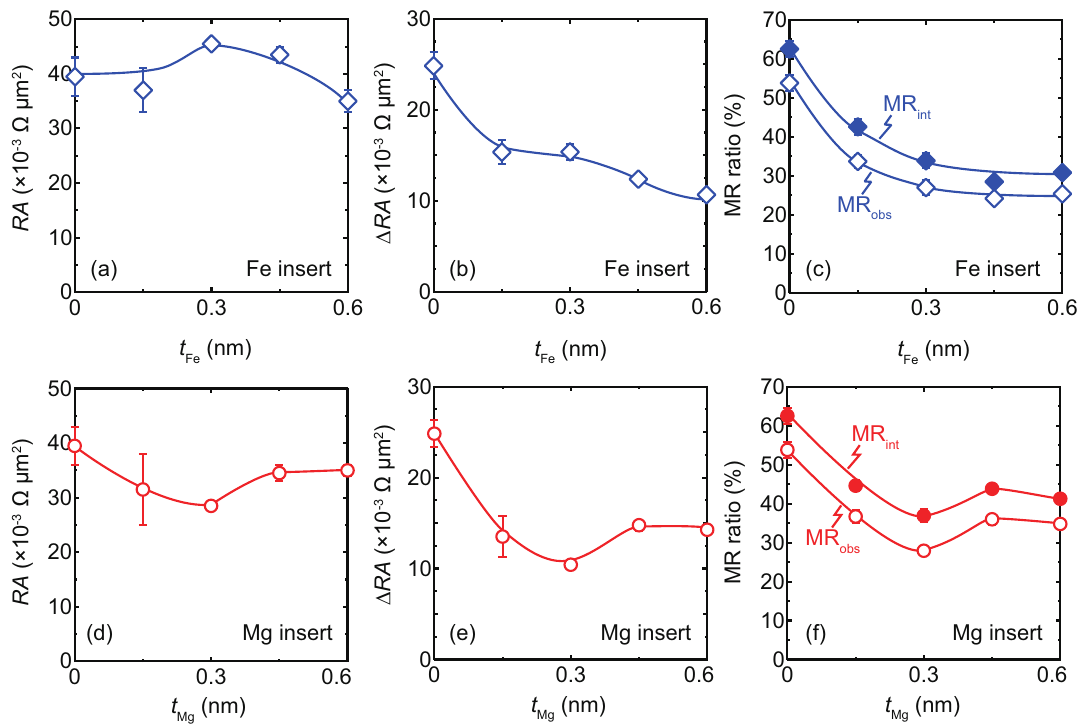
Figure 3. A summary of the insert thickness dependence of CPP-GMR at low bias current density for junctions with ( a – c ) Fe inserts and ( d – f ) Mg insert. ( a , d ) RA , ( b , e ) ∆ RA , and ( c , f ) MR ratios. Definitions of the observed MR ratio, MR obs , the intrinsic MR ratio, MR int , and ∆ RA are shown in Equation